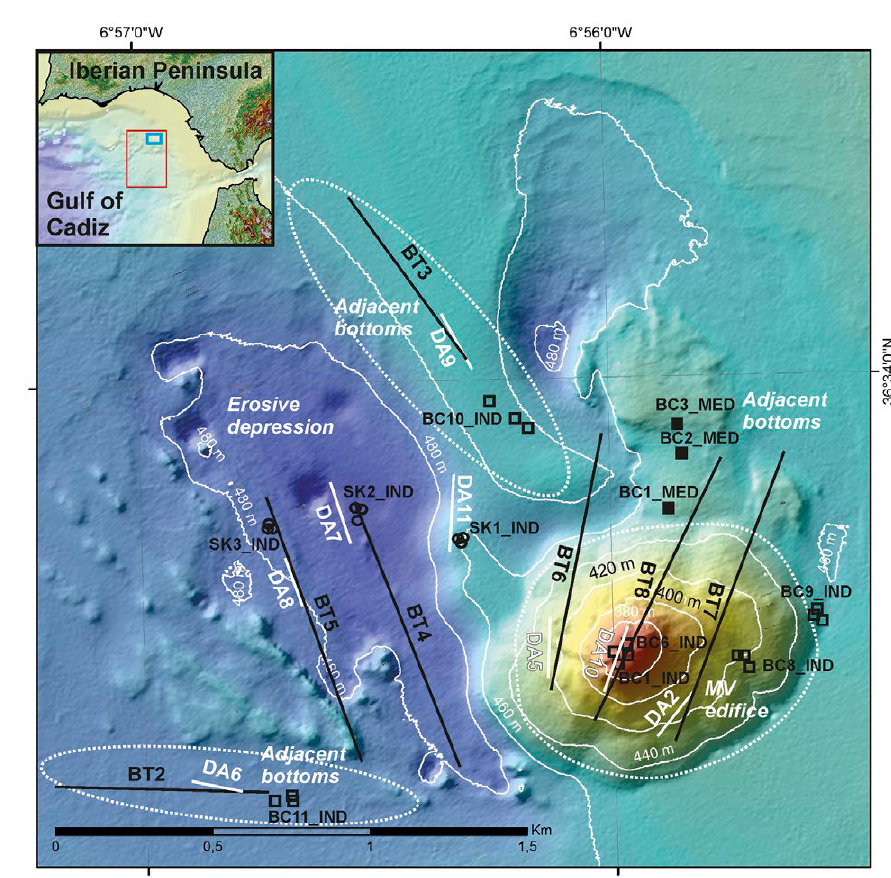
Fig. 1. – Location map of the Gazul mud volcano (MV) (blue frame) within the shallow field of fluid expulsion in the Gulf of Cádiz (red frame). Detailed map of the Gazul MV with the stations sampled with beam-trawl (BT) (black lines), benthic dredge (DA) (white lines), box-corer (BC) (squares) and Shipek grab (SK) (circles) during the INDEMARES/CHICA 0610, 0412 (IND, empty squares and circles) and ATLAS/MEDWAVES 0916 (MED, solid squares) oceanographic